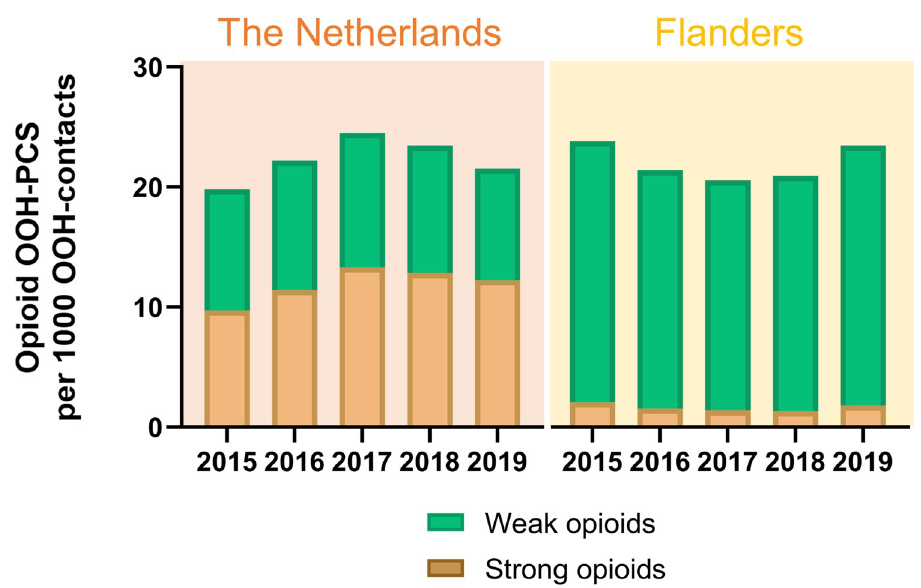
Fig 1. Opioid prescribing in out-of-hours primary care in the Netherlands (upper panel) and Flanders (lower panel) between 2015 and 2019, number of contacts with an opioid prescription per 1000 OOH-contacts. OOH-PCS = out-of-hours primary care